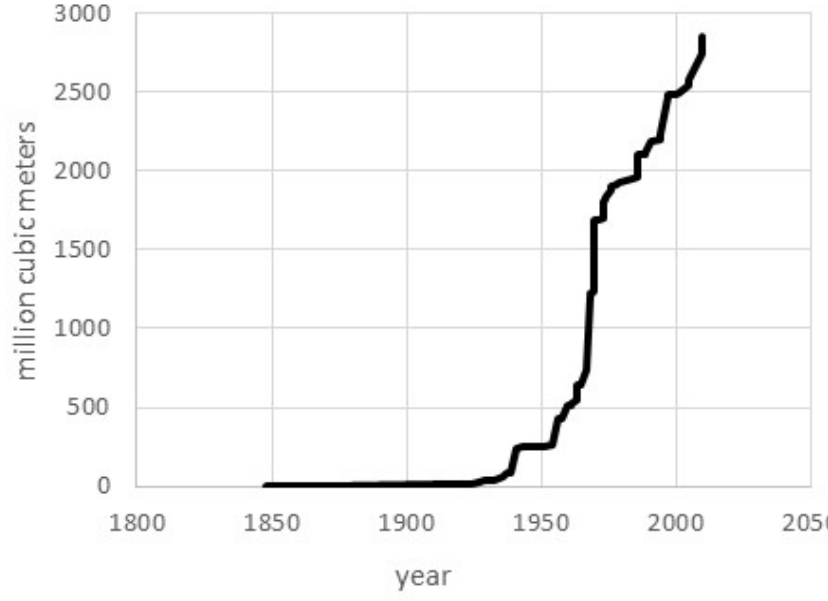
Figure 3. Cumulative total capacity of reservoirs in the Vistula basin.